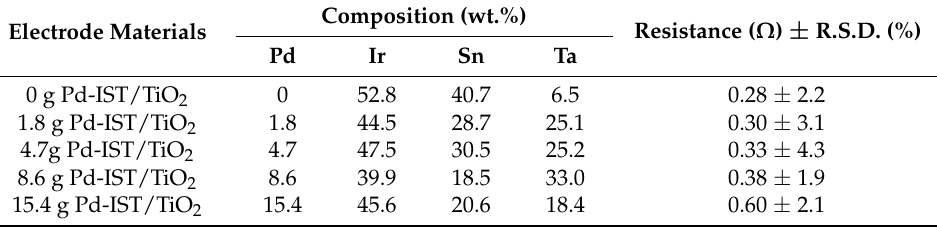
Table 2. EDAX analysis and resistance of commercial Pd-based electrodes. Composition Electrode Materials